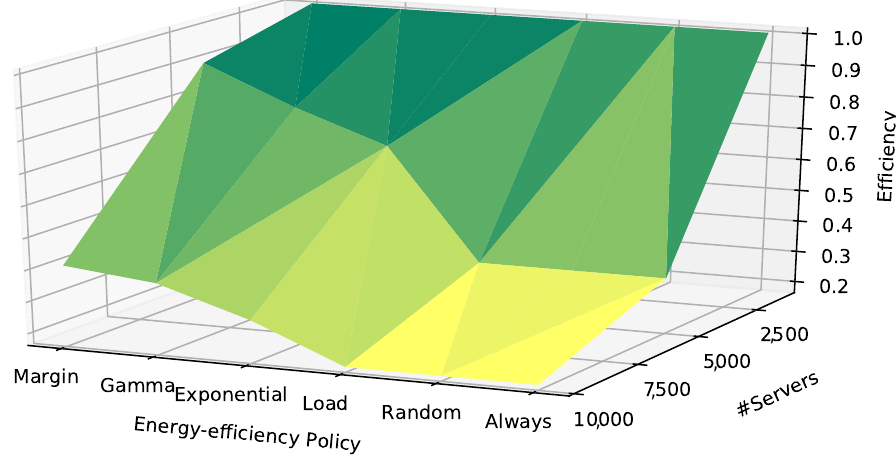
Figure 6. Summary of DEA natural constant returns to scale (CRS) efficiency results for energy efficiency policies.